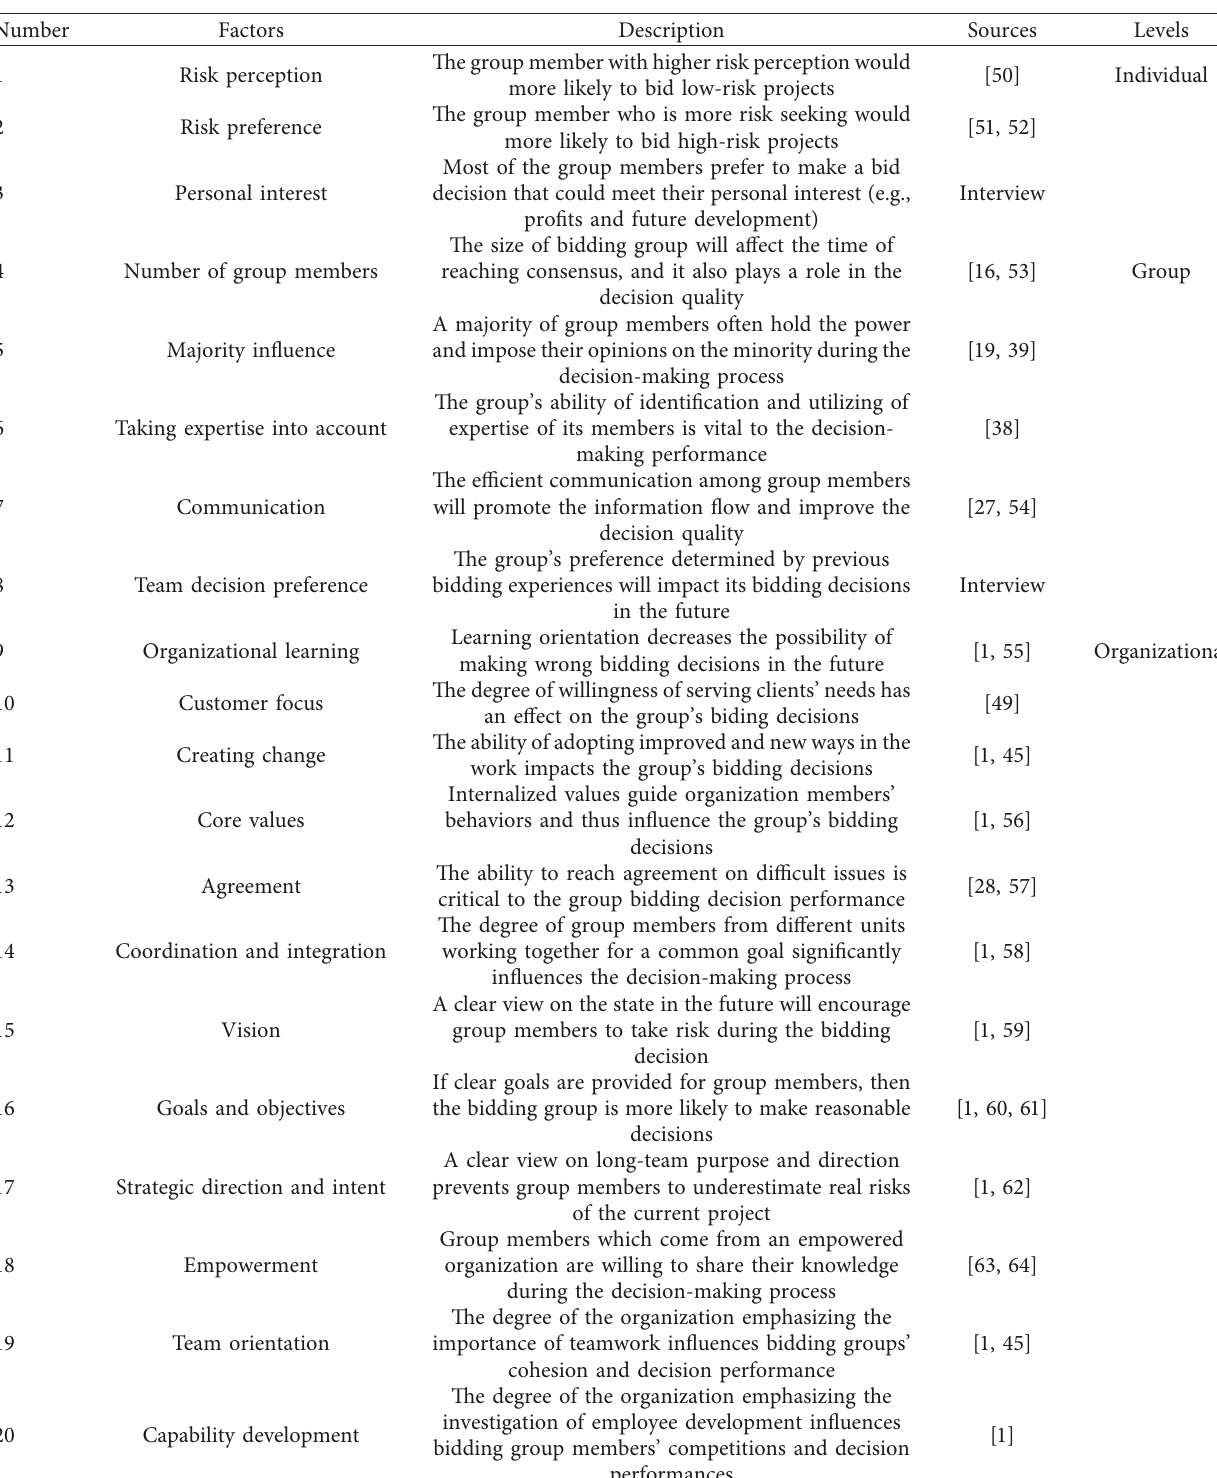
Table 1: Factors identified from the literature review and